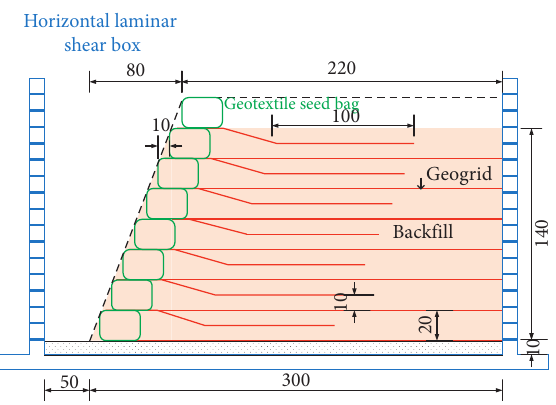
Figure 2: Schematic diagram of the geometric dimensions of the model (cm). Table 3: Mechanical parameters of filler.